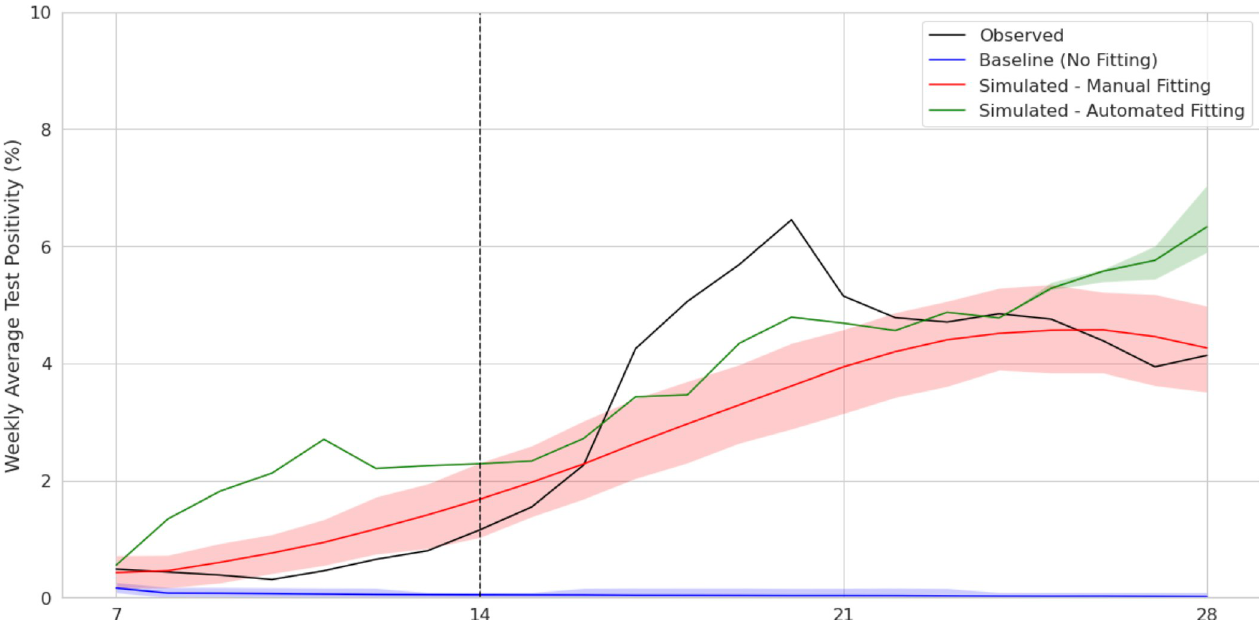
Fig 1. Comparison of weekly average test positivity and percentage change in weekly average test positivity, Scenario 1. Weekly average test positivity and 90% confidence intervals across 100 repeated runs each for baseline (no fitting), manual, and automated parameter fitting, compared with the observed ground truth.